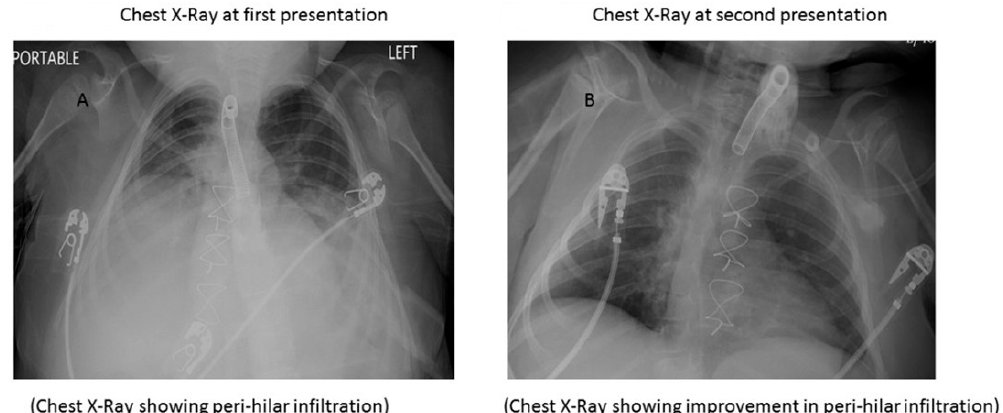
Figure 1. ( A ): Chest X-Ray (CXR): (Initial presentation) Perihilar infiltrates (Expiratory film) vs. ( B ): Second CXR with improvement in infiltrations.